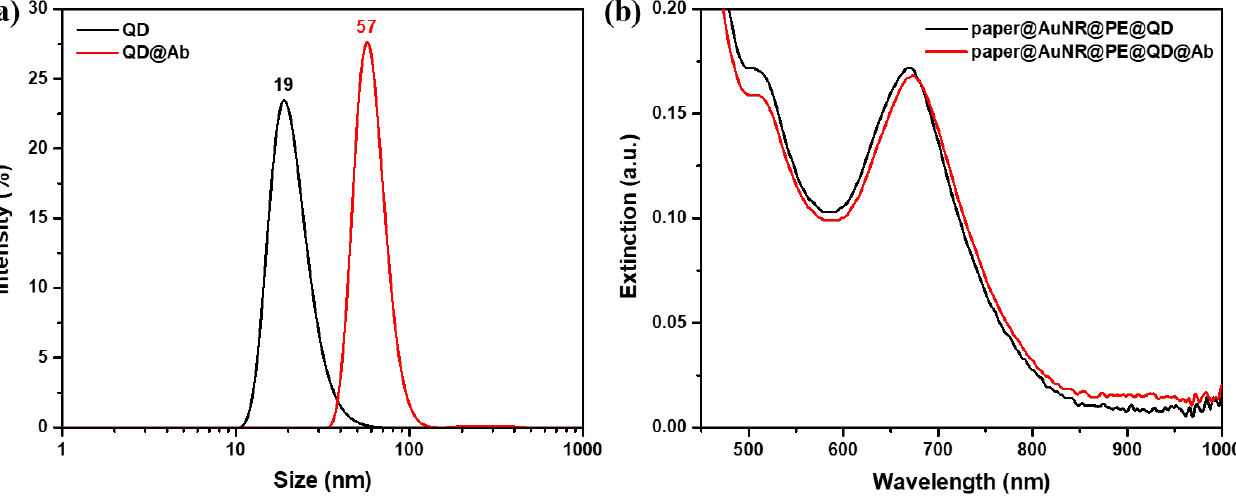
Figure 5. ( a ) DLS measurements of QD before (black spectrum) and after the covalent binding with Ab-CEACAM5 (red spectrum). ( b ) Comparison between the extinction spectra of paper@AuNR@PE after being decorated with free QD (black spectrum) and conjugated QD@Ab (red spectrum).